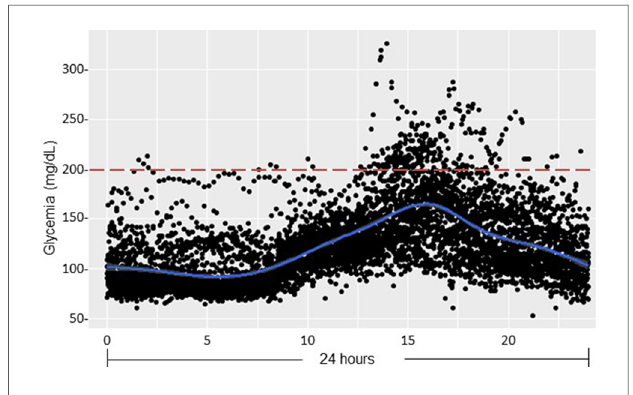
FIGURE 7 Glucose sensor data after pediatric renal transplantation (pDIABGRAFT). Data of the glucose sensor placed at day 14 post-RT for one month were regrouped on 24 h and showed hyperglycemia in postprandial afternoon period.